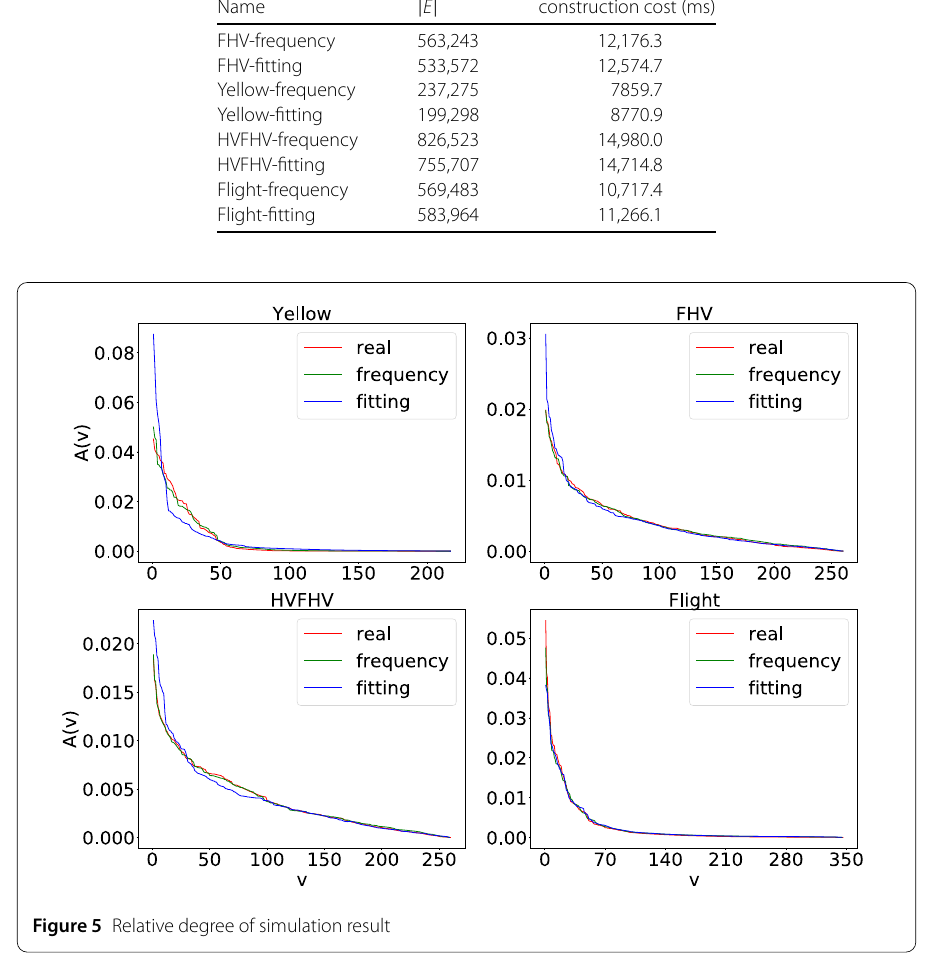
Figure 5 Relative degree of simulation